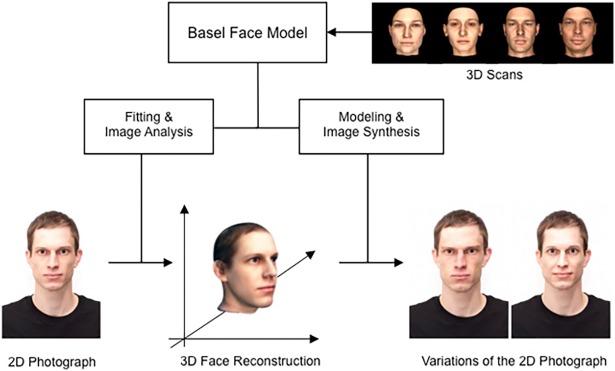
Visualization of the process to generate variations of an exemplar face on a specific personality dimension (here: Agreeableness).First, the face on the standardized and aligned photograph is reconstructed by fitting the Basel Face Model [26] to the face on the photograph. Second, the resulting 3D reconstruction of the face is manipulated on a specific personality dimension. Finally, the altered faces are rendered back into the 2D photograph, resulting in natural-looking images that vary regarding their value on the respective personality dimension.